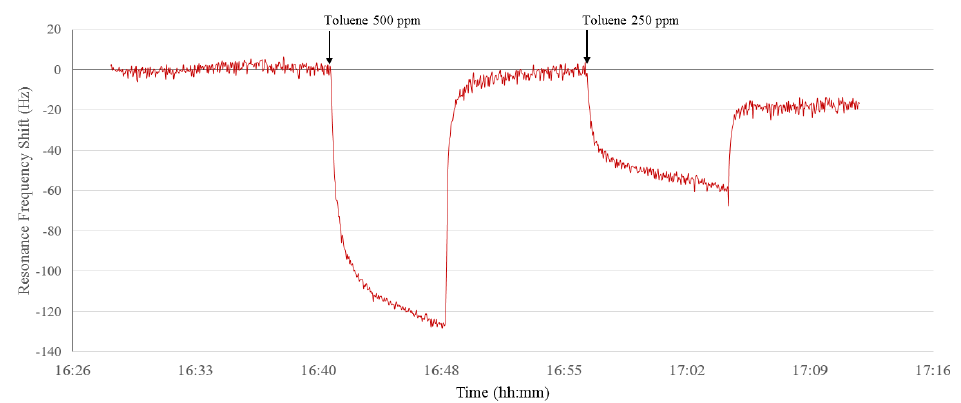
Figure 6. An example of detection of Toluene at 500 ppm and 250 ppm using new version of diamond cantilevers coated with PECH and new version of detection